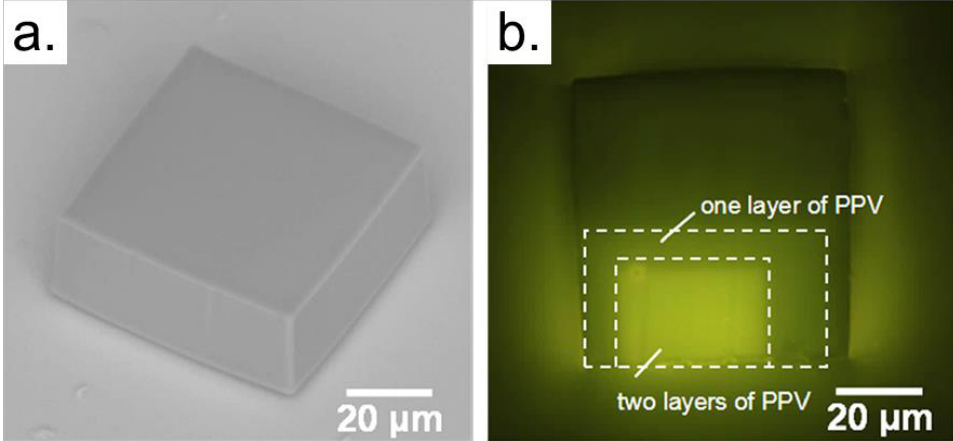
Figure 9. ( a ) SEM image of a polymeric microstructure fabricated by fs-laser writing via 2PP. ( b ) Fluorescence microscopy image of the microstructure shown after it was selectively mission [92]. Copyright © 2021, Springer Nature.